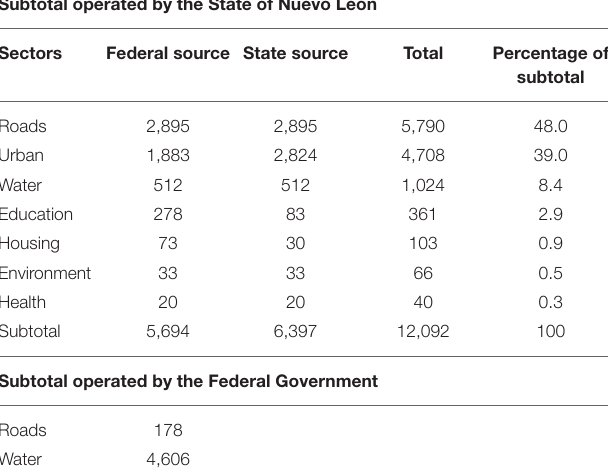
TABLE 4 | Reconstruction expenditures, sources of finance and operation of funds, 2013 (millions of pesos). Subtotal operated by the State of Nuevo